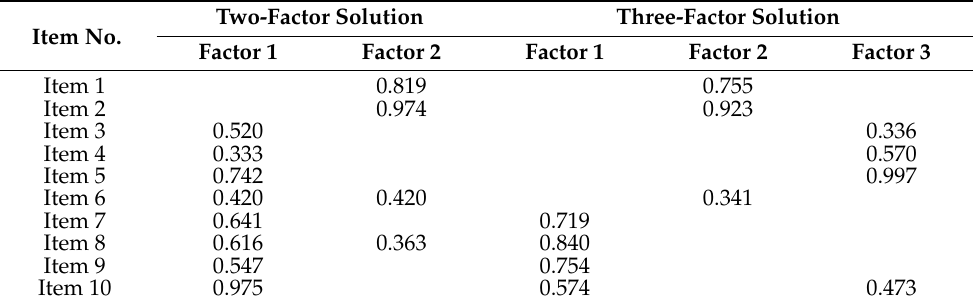
Table 3. Factor matrix for the EPDS in the T1 Slovak sample (exploratory factor analysis with oblimin